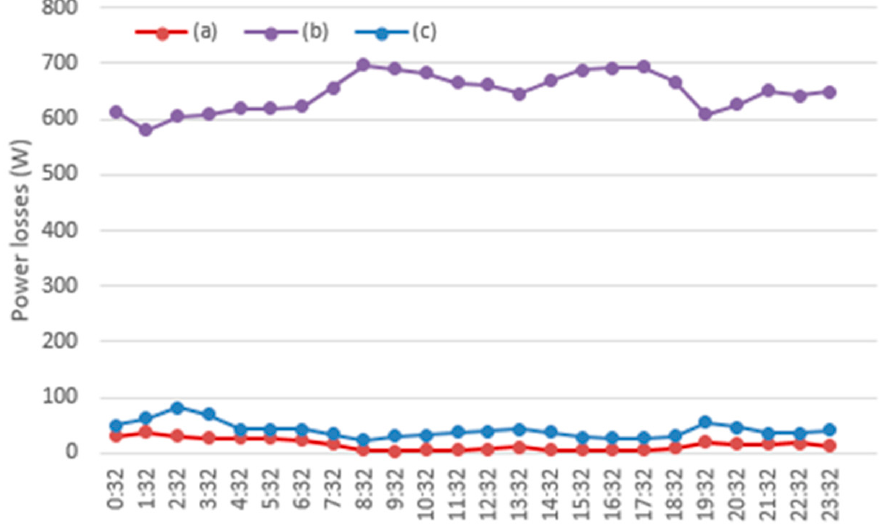
Figure 7. Transformer power losses in holidays due to (a) active currents ( P ca ); (b) reactive currents with capacitors ( P (cid:48) cr ) and (c) reactive currents without capacitors ( P cr ).